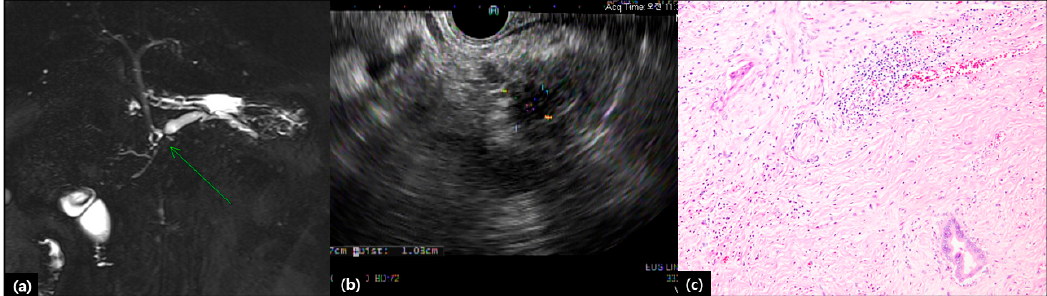
Figure 5. A case with extremely appropriate pancreatic cancer for LPD. A case of early pancreatic cancer in a 71-year-old, male patient, incidental finding of pancreatic duct dilatation during routine medical check-up. Preoperative image studies showed less than 1 cm sized pancreatic mass with secondary pancreatic duct dilatation ( a , b ). Type 0 LPD was performed on 24 October 2019, and discharged 9 days postoperatively. Pathological examination reported 3.0 mm-sized pancreatic ductal adenocarcinoma with good differentiation (×100, c ). resected margins were free from malignant cells (safety margin ≥ 1cm). No lymph node metastasis was noted among 23 retrieved lymph nodes.